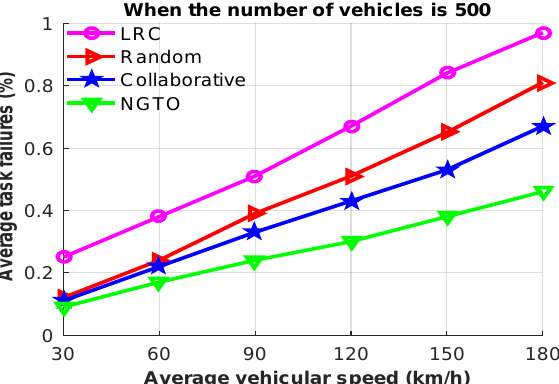
Figure 10. The average task-failure rates for different vehicular